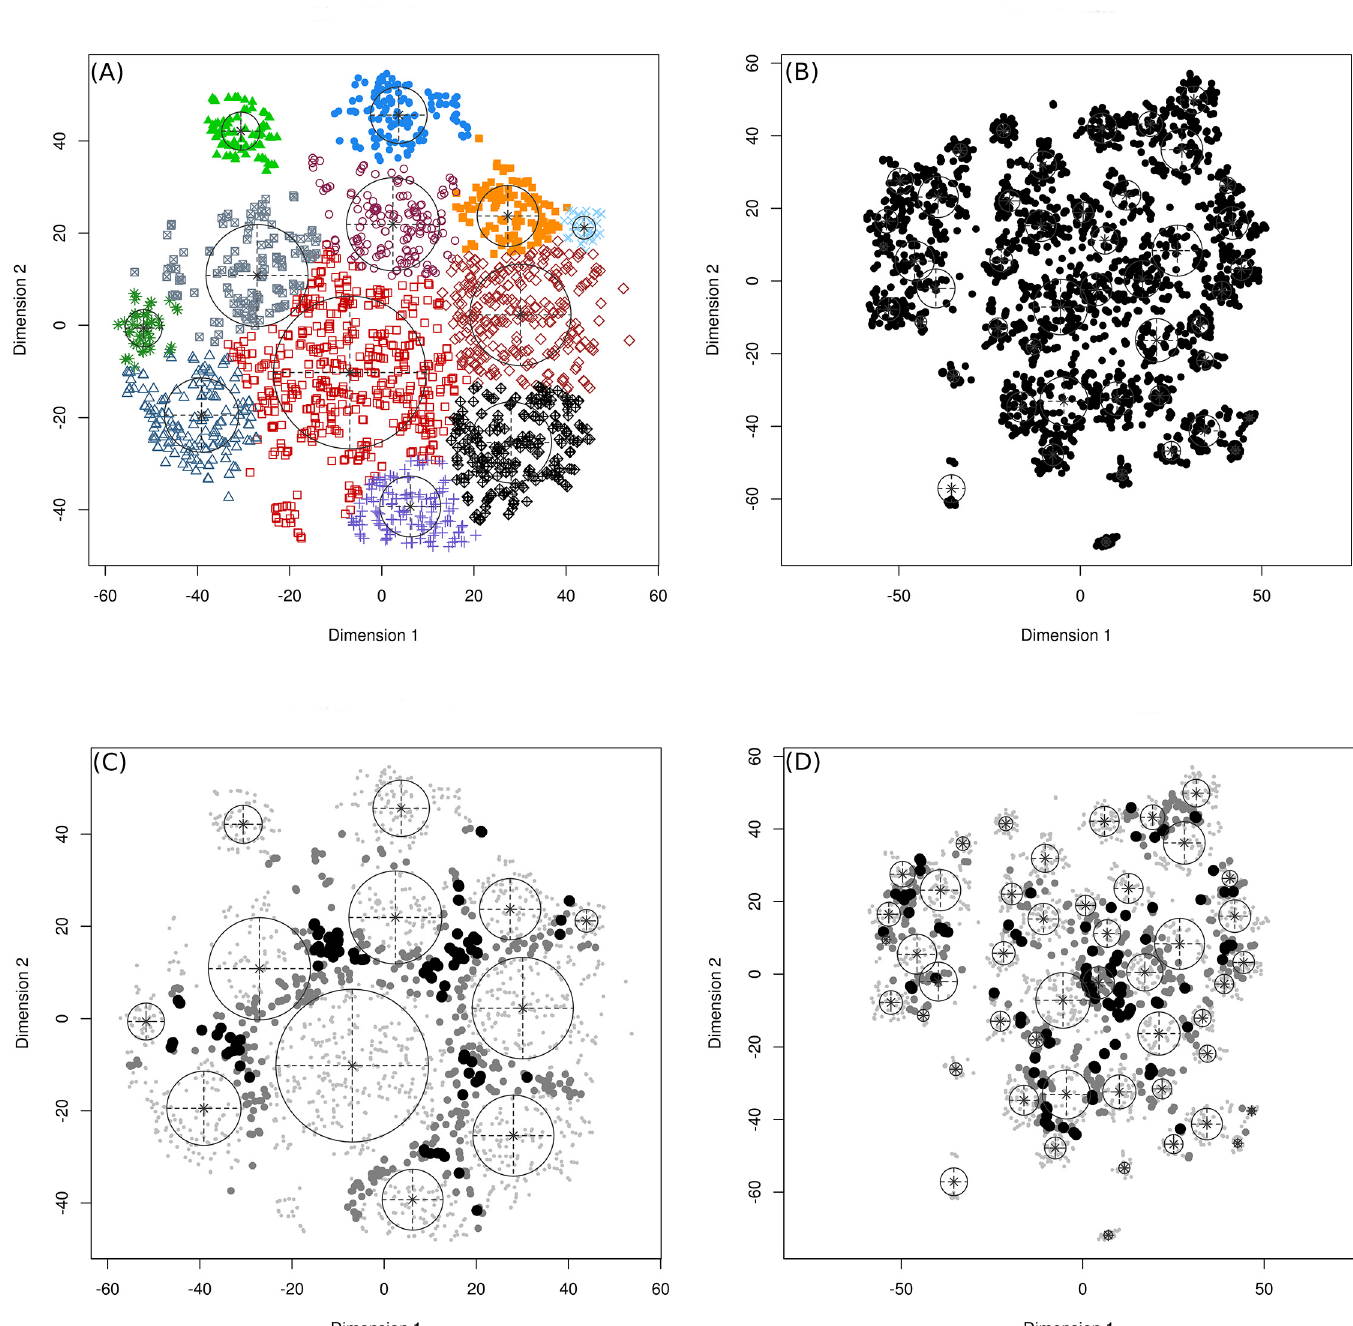
Fig 3. The results and uncertainty of model-based clustering. Clusters of the transformed contextual information about (A) cloned lilac and (B) common lilac. The uncertainty in clustering of transformed contextual information about (C) cloned lilac and (D) common lilac. In uncertainty plot, the symbols have the following meaning: large filled symbols, 95% quantile of uncertainty; smaller open symbols, 75 – 95% quantile; small dots, first three quartiles of uncertainty.